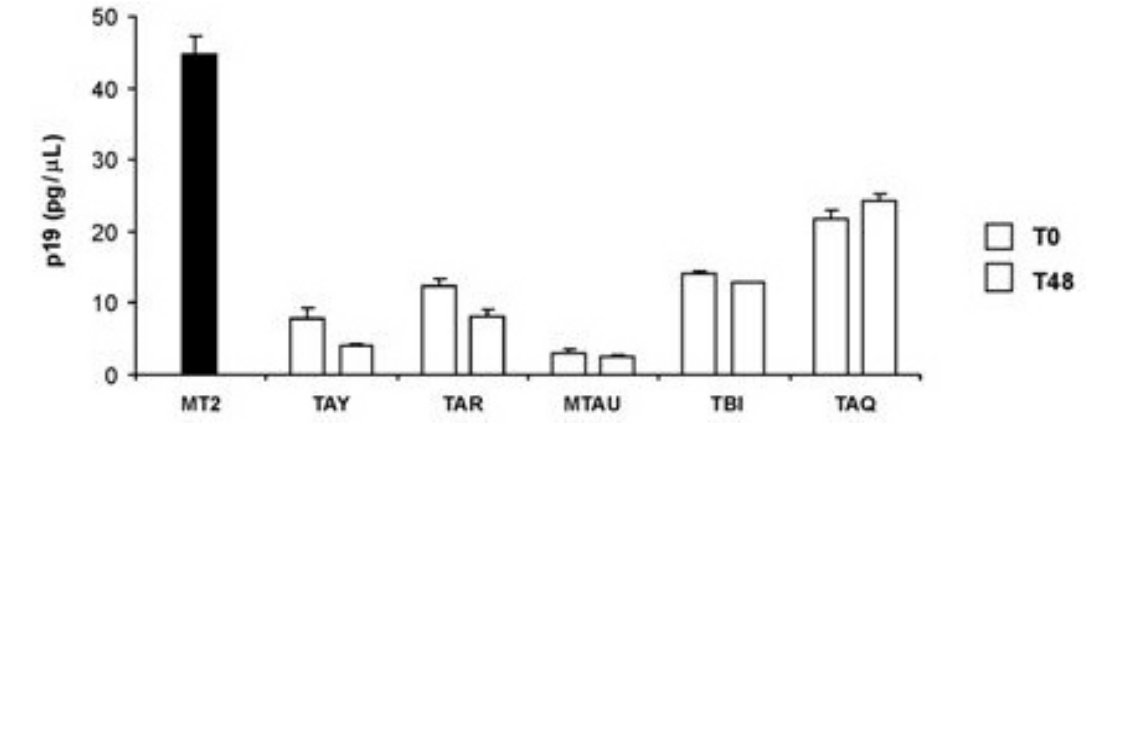
Figure 2. p19 release in culture supernatants from PBMCs of HAM patients before and after therapy. The p19 concentration in supernatants from PBMC cultures of 5 patients with HAM (TAY, TAR, TAU, TBI, TAQ), before (T0) and after (T48) therapy with 3TC plus AZT, was evaluated by ELISA. Values are expressed as the mean of quadruplicate samples ± standard deviation. Production of p19 (black column) in the supernatant of chronically infected cells MT-2 was used as a positive